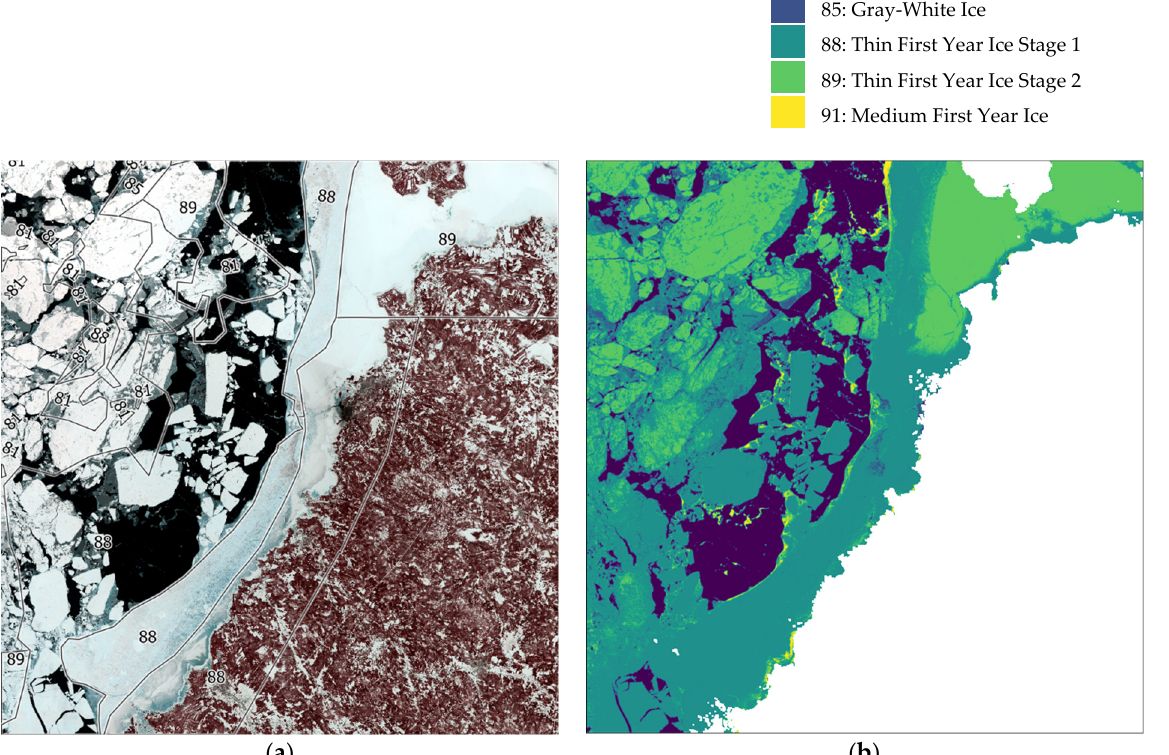
Figure 12. ( a ) Landsat-8 false color for 22 March 2019; BSH ice chart for 21 March 2019; ( b ) ICESOD classification.